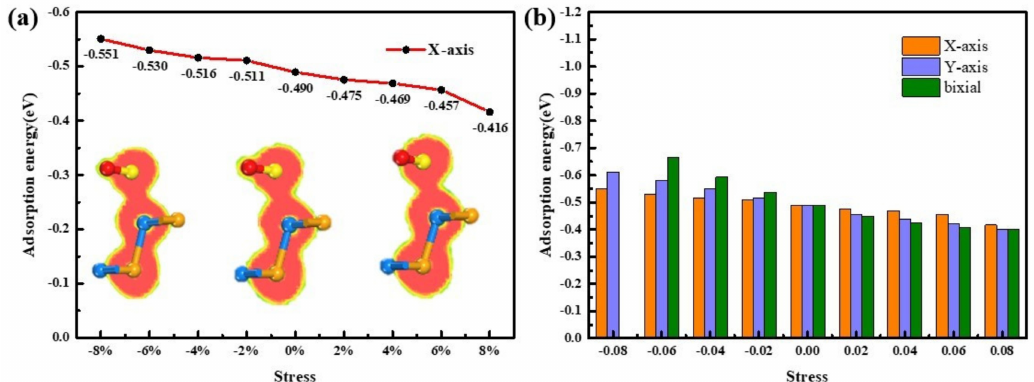
Figure 9. ( a ) The change curves of E ad with tensile strain from − 8% to 8% in SO 2 / strained-SiSe systems, ELFfromlefttorightrepresents − 8%, 0%, and8%ofstress. ( b )Thecomparisonofadsorptionenergywith the X-axis, Y-axis, and biaxial under compressive strain from -8% to 8% in NH 3 / strained-SiSe